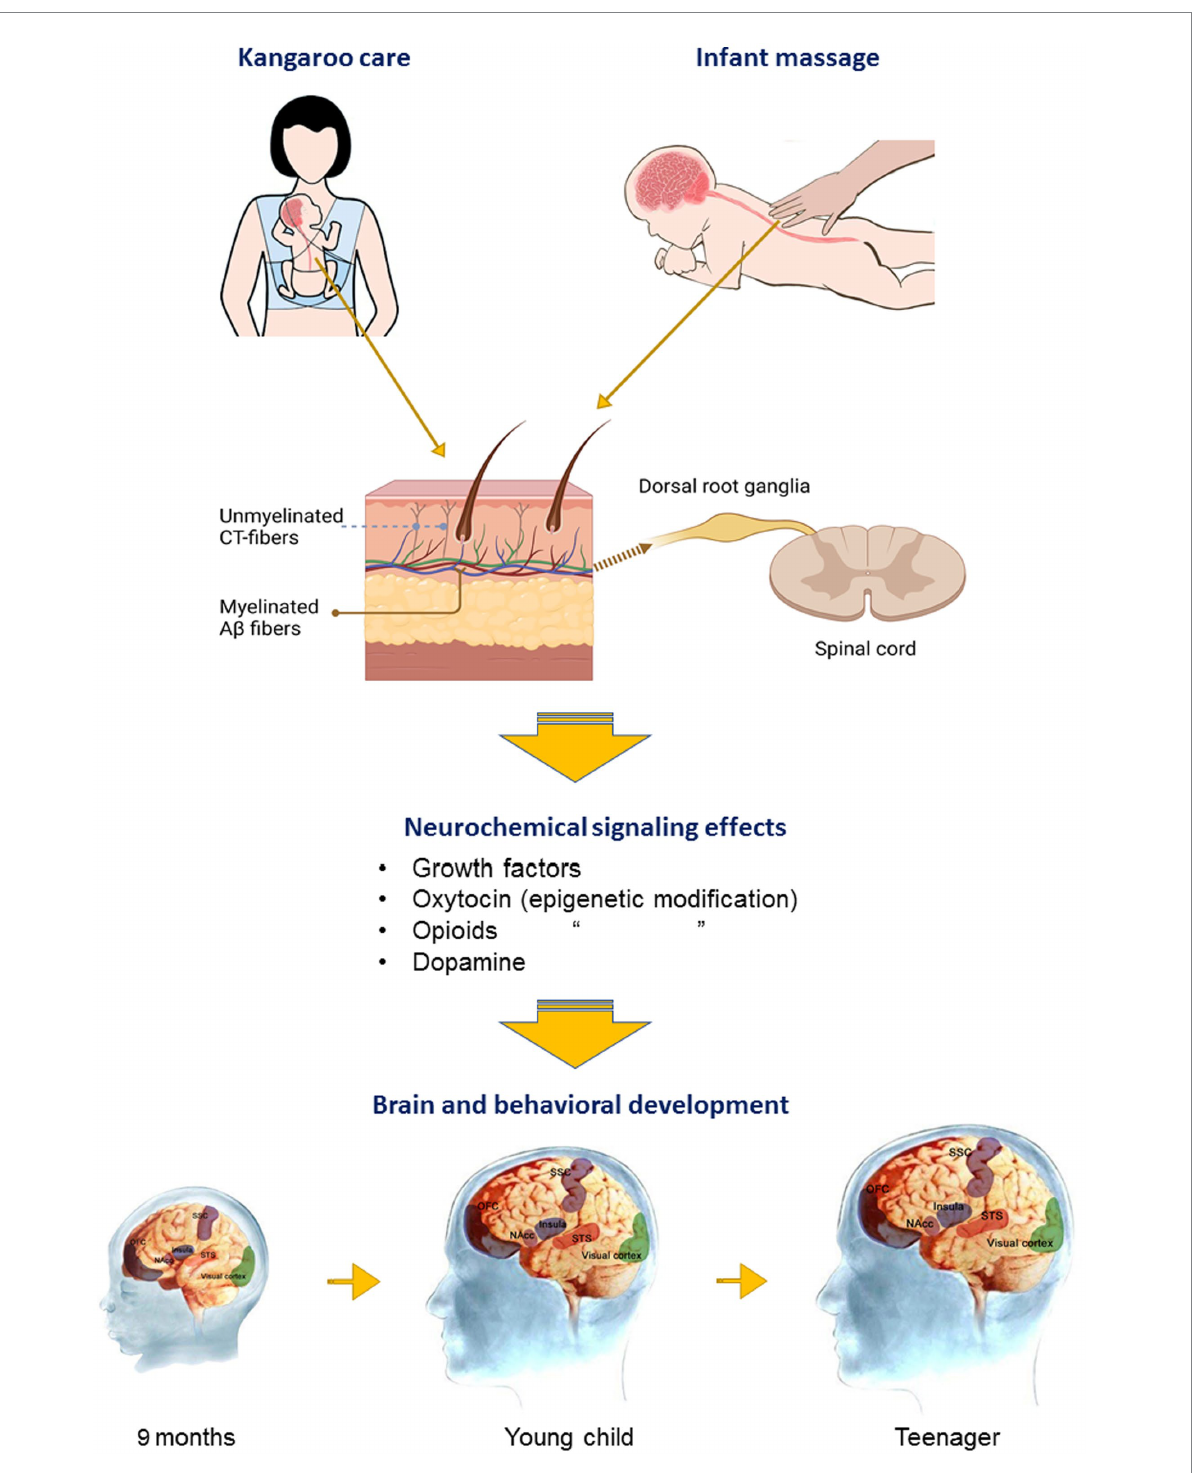
FIGURE 1 Influence of affective touch on brain development. Schematic illustrates effects of either parental touch (Kangaroo touch) or pediatric massage on cutaneous fibers for affective (CT-fibers) or discriminative touch (A β ) and projections to the brain via the dorsal route ganglia and spinal cord. Affective touch in particular promotes brain development and cognitive and social behavior via stimulation of growth factors, and oxytocin, opioid, and dopamine release and signaling and epigenetic modification. These neurochemical systems help to mediate developmental changes via neural plasticity and integration of brain circuitry sub-serving sensory (visual cortex, somatosensory cortex—SSC), salience (insula cortex), reward (orbitofrontal cortex, OFC and nucleus accumbens, NAcc), and social cognition (superior temporal cortex, STS) processing. Responses of the STS to touch are not fully developed until around 12 months of